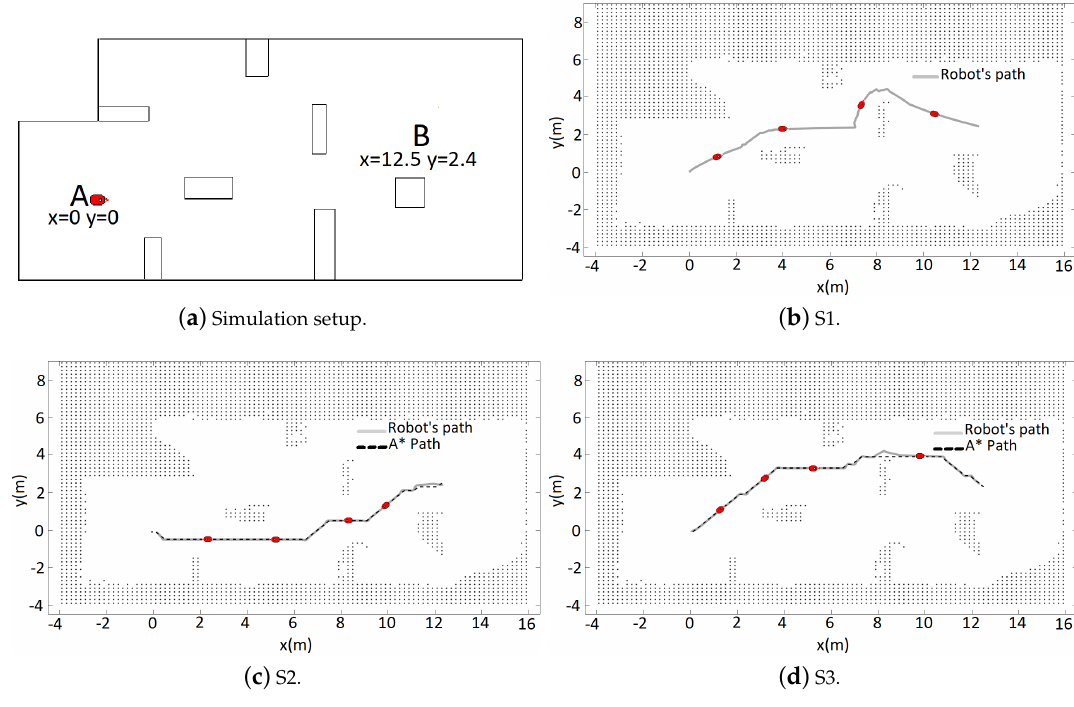
Figure 5. Navigation and